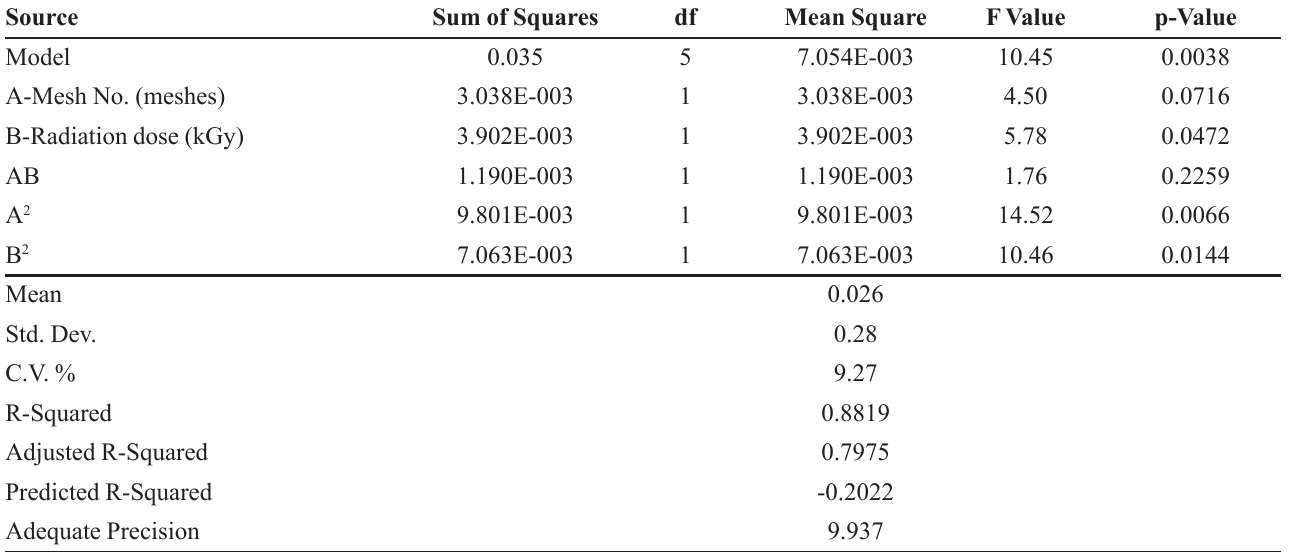
TABLE IIB - Analysis of variance (ANOVA) from the final reduced models for for iron chelating activity of gamma irradiated maize flour